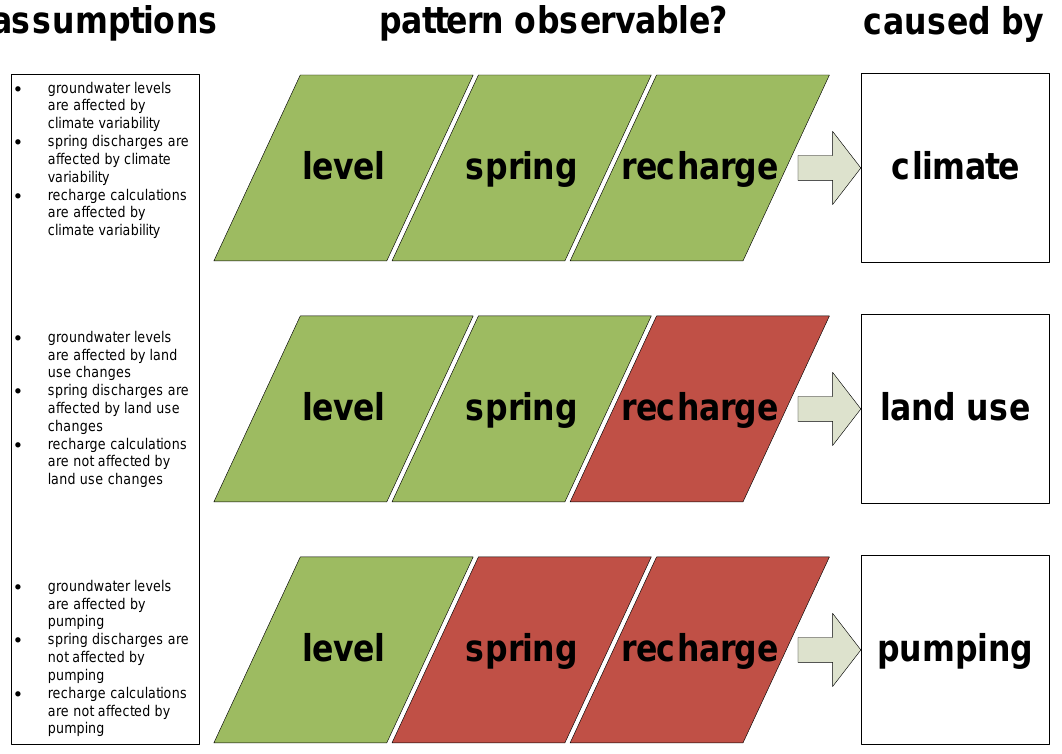
Fig. 8. Qualitative procedure to identify the possible reasons for observed patterns. If a pattern (e.g. a trend) can be observed in a specific data source (e.g. groundwater level) it is marked green. If not, the data source is marked red. Other combinations than the ones displayed, did not